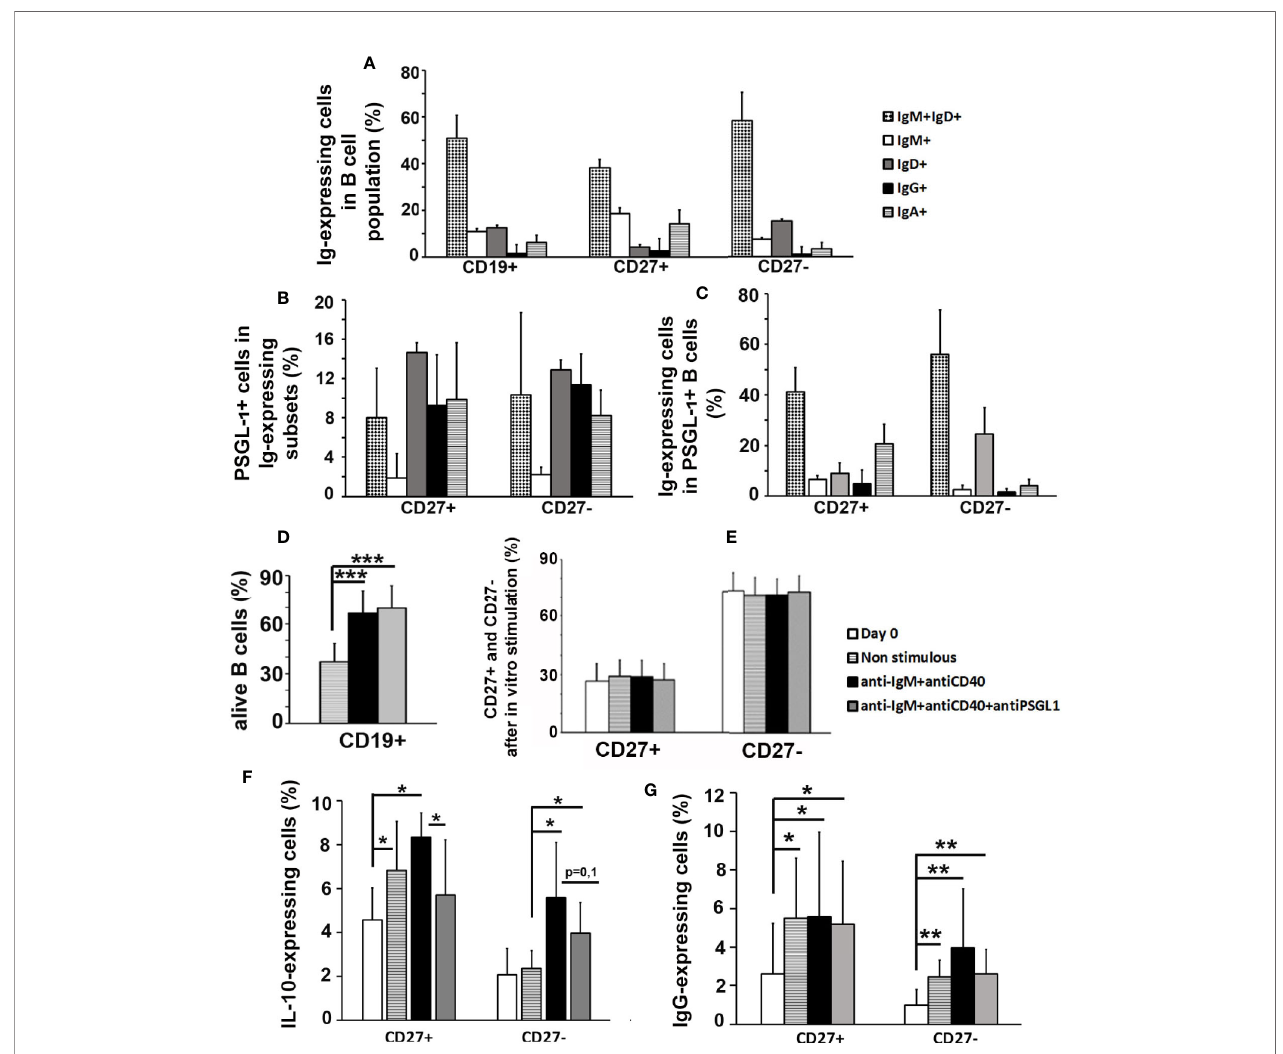
FIGURE 6 | PSGL-1 signaling inhibits in vitro activation of human peripheral B cells. (A) Relative frequencies of the different immunoglobulin (Ig)-expressing cell subsets in human total B cells (CD19 + ) and in the CD27 + and CD27 − B cell subpopulations. (B) Percentage of PSGL-1 + cells in the different Ig- expressing subsets of CD27 + and CD27 − B cells. (C) Relative frequencies of the different Ig- expressing cell subsets in the PSGL-1 + B cell subpopulation. (D) Percentage of surviving B cells after 72 h in culture: non-stimulated, activated with anti-IgM+anti-CD40 antibodies or activated with anti-IgM+anti-CD40+anti-PSGL-1 antibodies. (E) Relative frequency of CD27 + and CD27 − B cells in the total B cell population after 72 h in culture: non-stimulated, activated with anti-IgM+anti-CD40 antibodies or activated with anti-IgM+anti-CD40+anti-PSGL-1 antibodies. (F, G) Percentage of IL-10 + (F) and IgG + (G) cells in CD27 + and CD27 − B cells after 72 h in culture: non- stimulated, activated with anti-IgM+anti-CD40 antibodies or activated with anti-IgM+anti-CD40+anti-PSGL-1 antibodies. Bars represent the mean+standard deviation. *p < 0.05, **p < 0.01 by one-way ANOVA test. In all cases, n =